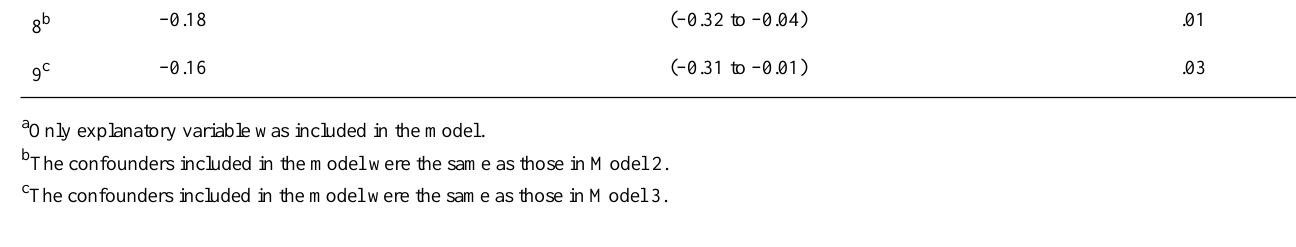
Table 8. Results of analyzing the influence of “accessing the internet” on the choice of hospital (ref=primary hospital).